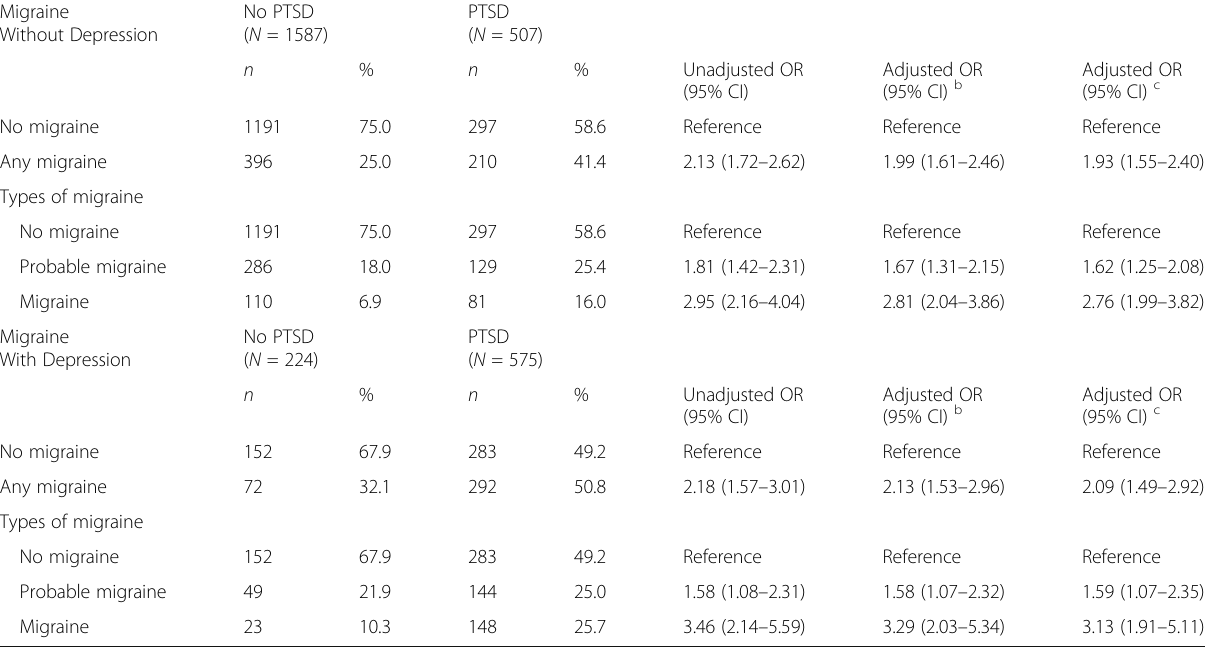
Table 3 Association between migraine and PTSD a during pregnancy ( N = 2922) stratified by depression status Migraine No PTSD Without Depression ( N =